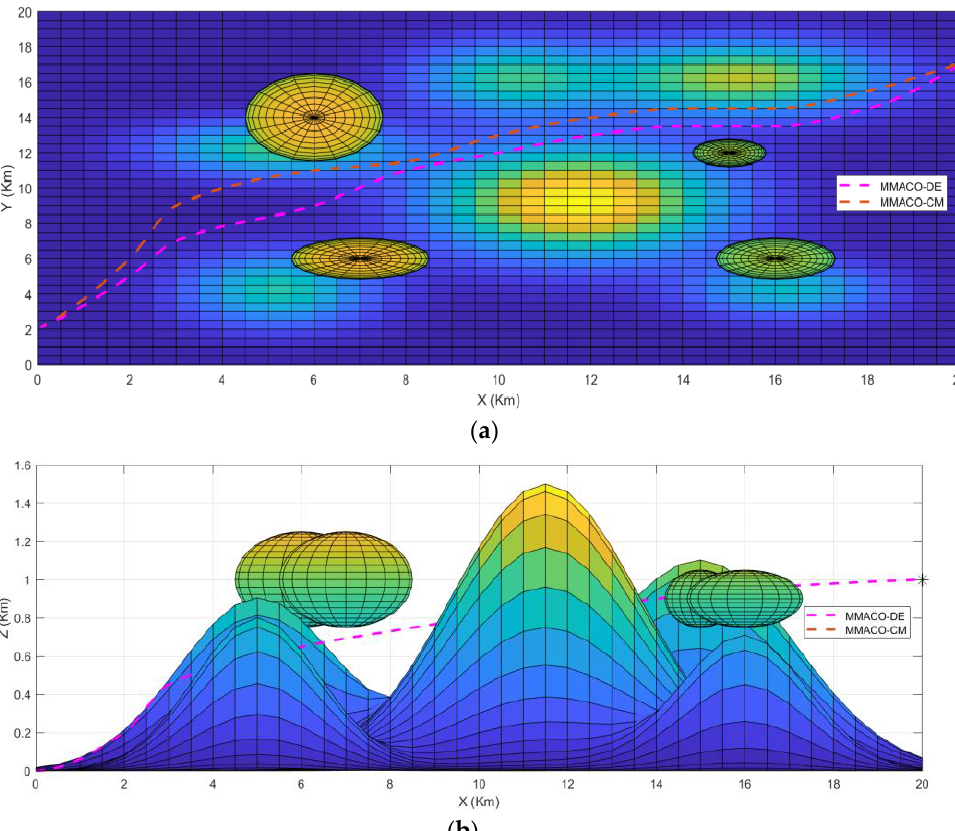
Figure 3. ( a , b ) Case1; 2D views of path followed by UAV1(MMACO-DE) and UAV2 (MMACO-CM) to the target (*).